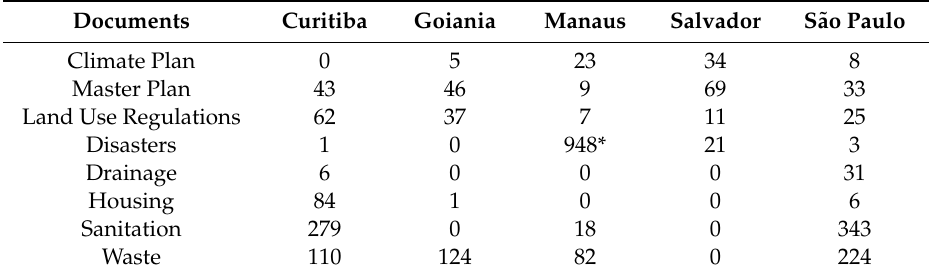
Table 14. References to health in city sectoral